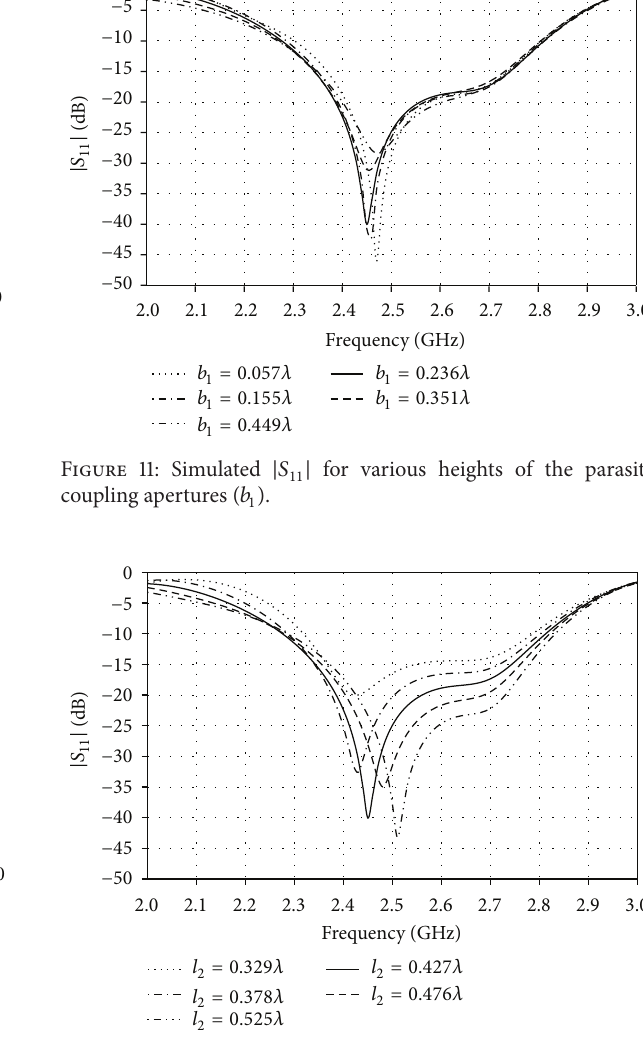
Figure 12: Simulated |𝑆 11 | for various lengths of the parasitic coupling apertures ( 𝑙 2